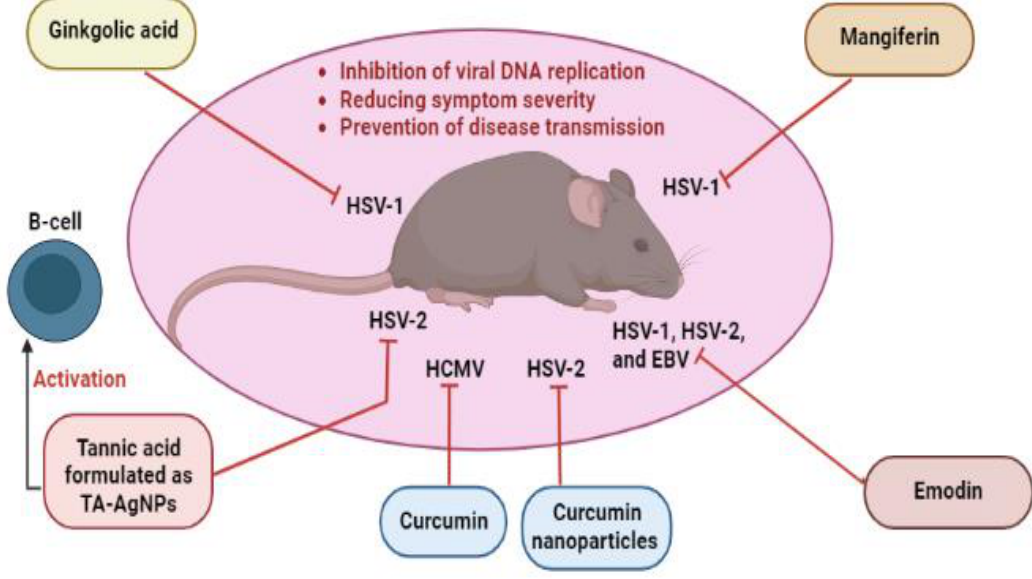
Figure 2. Non-flavonoid polyphenols with anti-herpesvirus properties validated by animal experi- ments. EBV, Epstein–Barr virus; HCMV, human cytomegalovirus; HSV-1, herpes simplex virus type 1; HSV-2; herpes simplex virus type 2; TA-AgNPs, tannic acid-modified silver nanoparticles.